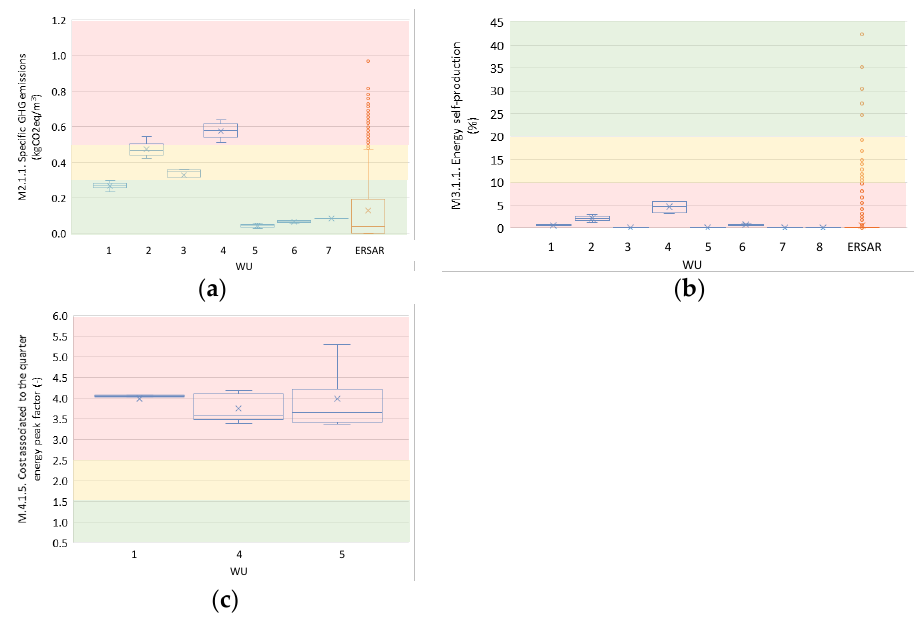
Figure 6. Results for the selected metrics of Objectives 2, 3, and 4: ( a ) M2.1.1; ( b ) M3.1.1; and ( c ) M4.1.5.